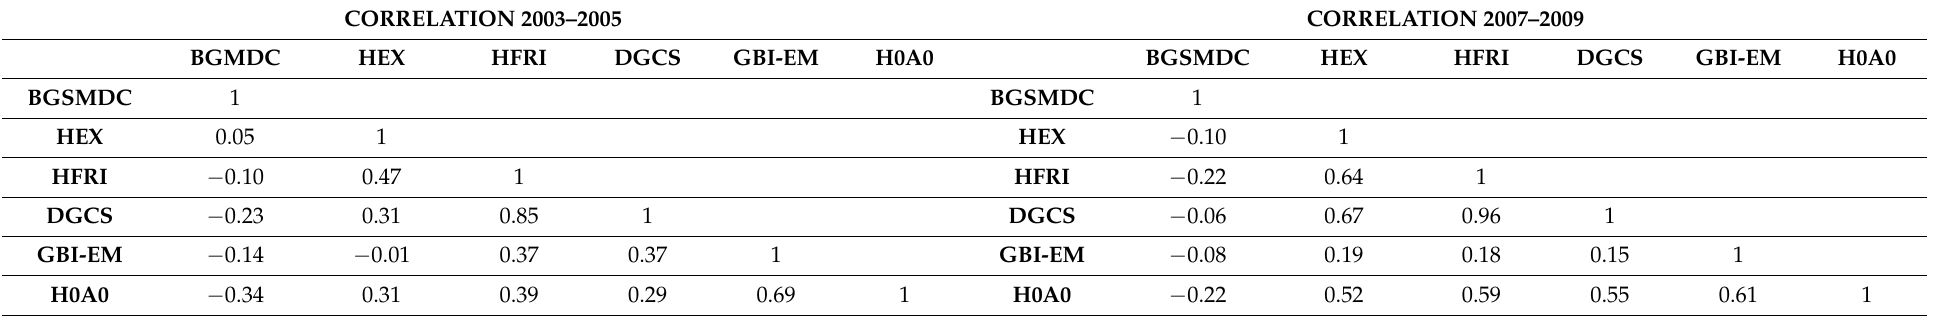
Table 3. Correlation matrix for all assets. Source: